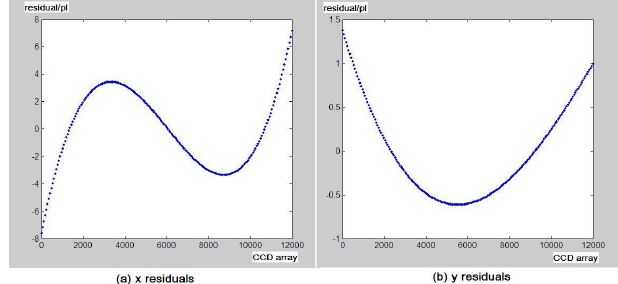
Figure 2. Residuals of IO estimation for THEOS imagery.